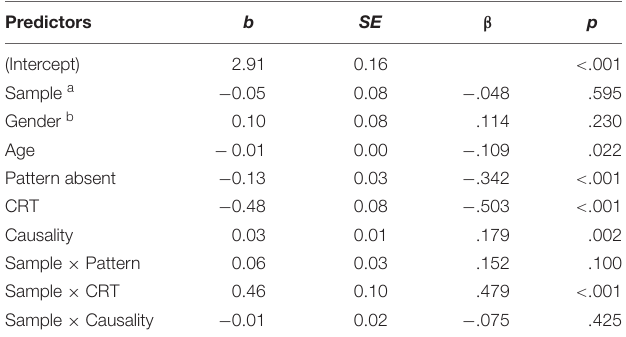
TABLE 7 | Regression analysis predicting bullshit receptivity by reflective thinking, holistic cognition, illusory pattern perception, and interactions with sample (Study